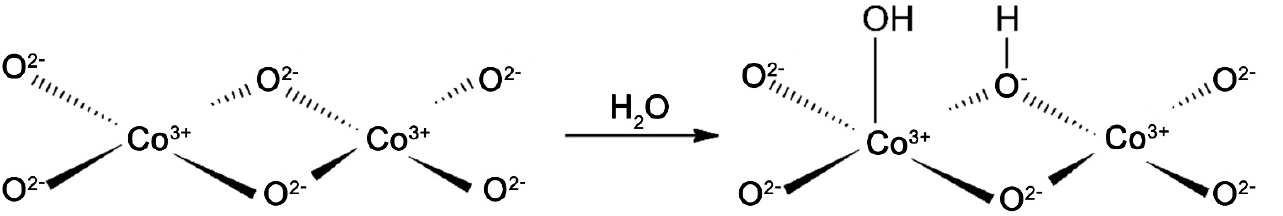
Figure 1. The dissociation of water molecule on Co 3 O 4 surface.